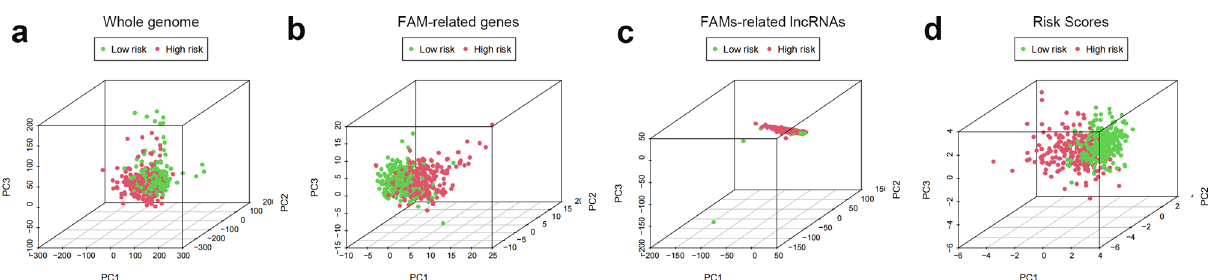
Figure 9. Internal validation of OS prediction signatures based on internal datasets. ( a ) Training group Kaplan ‒ Meier survival curves. ( b ) Test group Kaplan ‒ Meier survival curves. ( c ) ROC curves and AUCs for 1-, 3-, and 5-year survival in the training group. ( d ) ROC curves and AUCs for 1-, 3-, and 5-year survival in the test group. ROC, receiver operating characteristic; AUC, area under the curve; OS, overall survival.